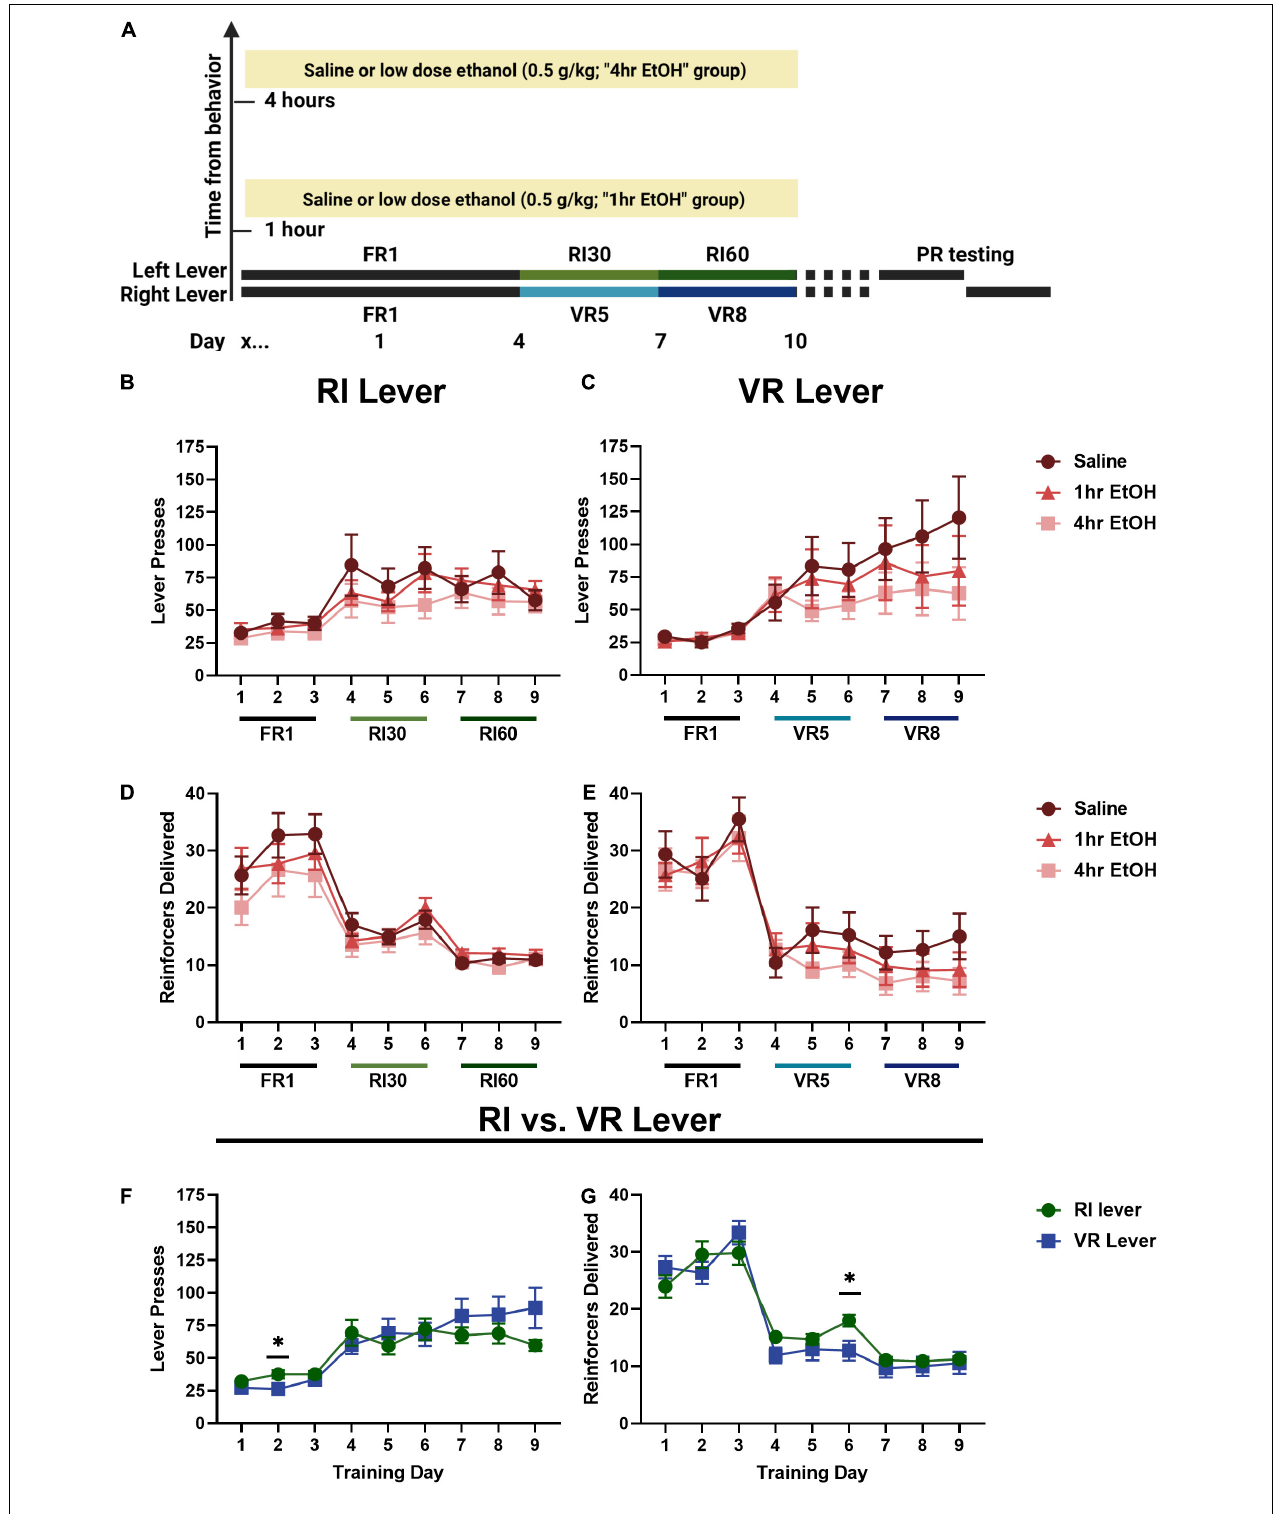
FIGURE 1 | Low dose ethanol exposure does not impact basal reward seeking in males. (A) A timeline of the behavioral experiments and ethanol exposure. In males, there is no effect of low dose ethanol exposure on responding during training on the RI (B) or VR (C) lever. There is also no effect of low dose ethanol exposure on reinforcer delivery during training on the RI (D) or VR (E) lever. Overall, neither lever pressing (F) nor reinforcer delivery (G) was different on the RI or VR lever for males. Data shown as mean ± SEM ( ∗ p < 0.05).